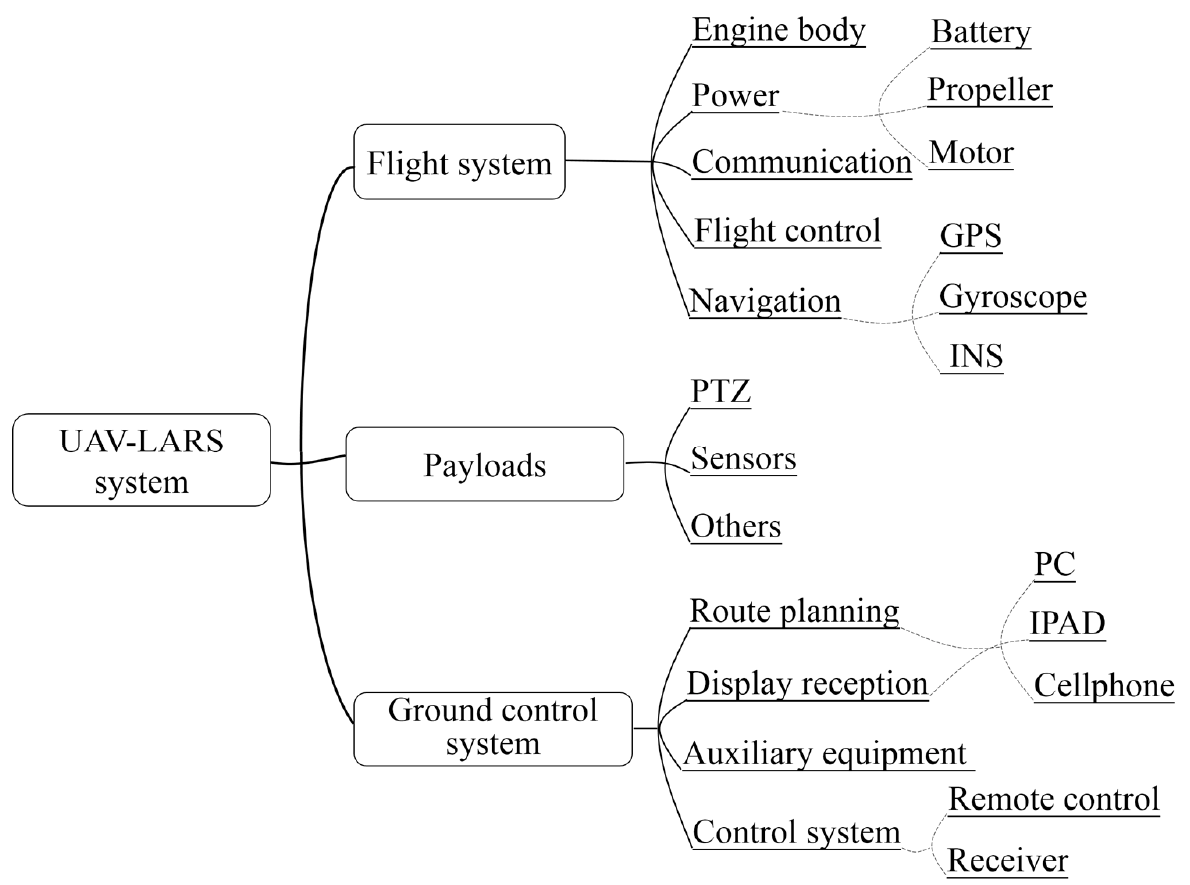
Figure 1. Composition of the unmanned aerial vehicle low-altitude remote sensing (UAV-LARS) monitoring system.